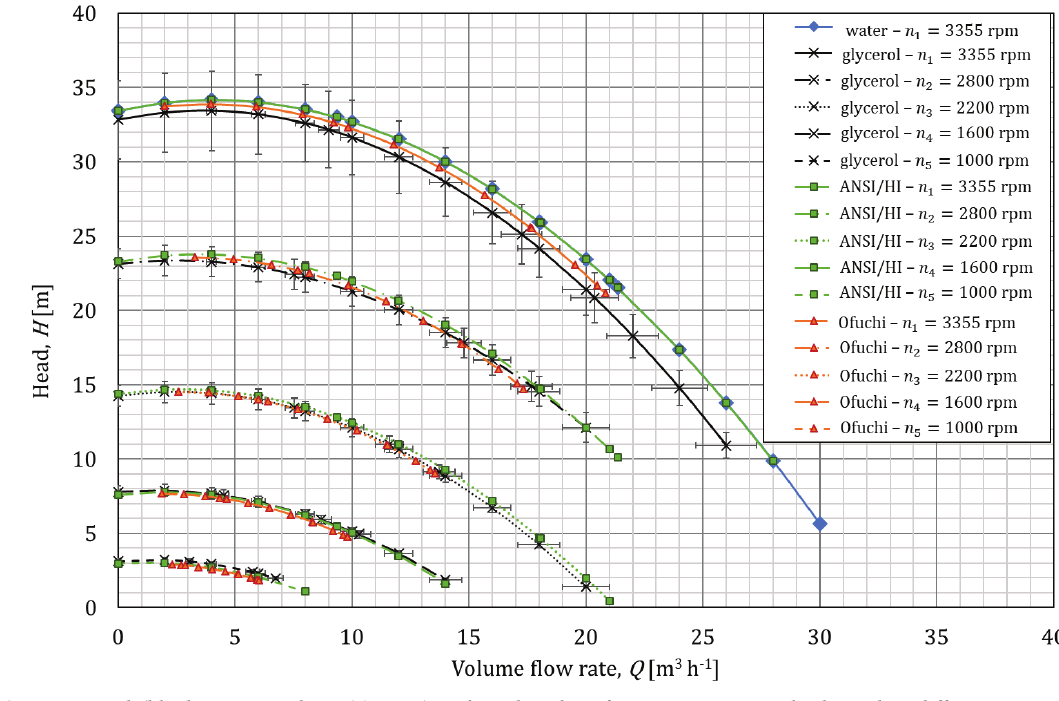
Fig. 6 – Measured (black curves with ± 5 % error) and predicted performance curves with glycerol at different rotational speeds with measured baseline curve with water as reference (thick blue with ◊). Green □: predicted with ANSI/HI method, orange Δ: predicted with Ofuchi